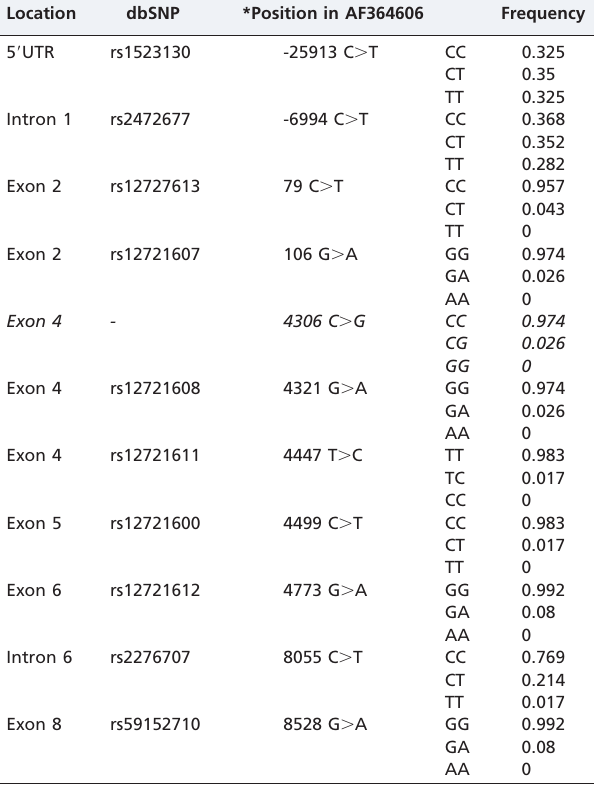
Table 2 - Genotypic frequency of polymorphisms in the PXR gene in